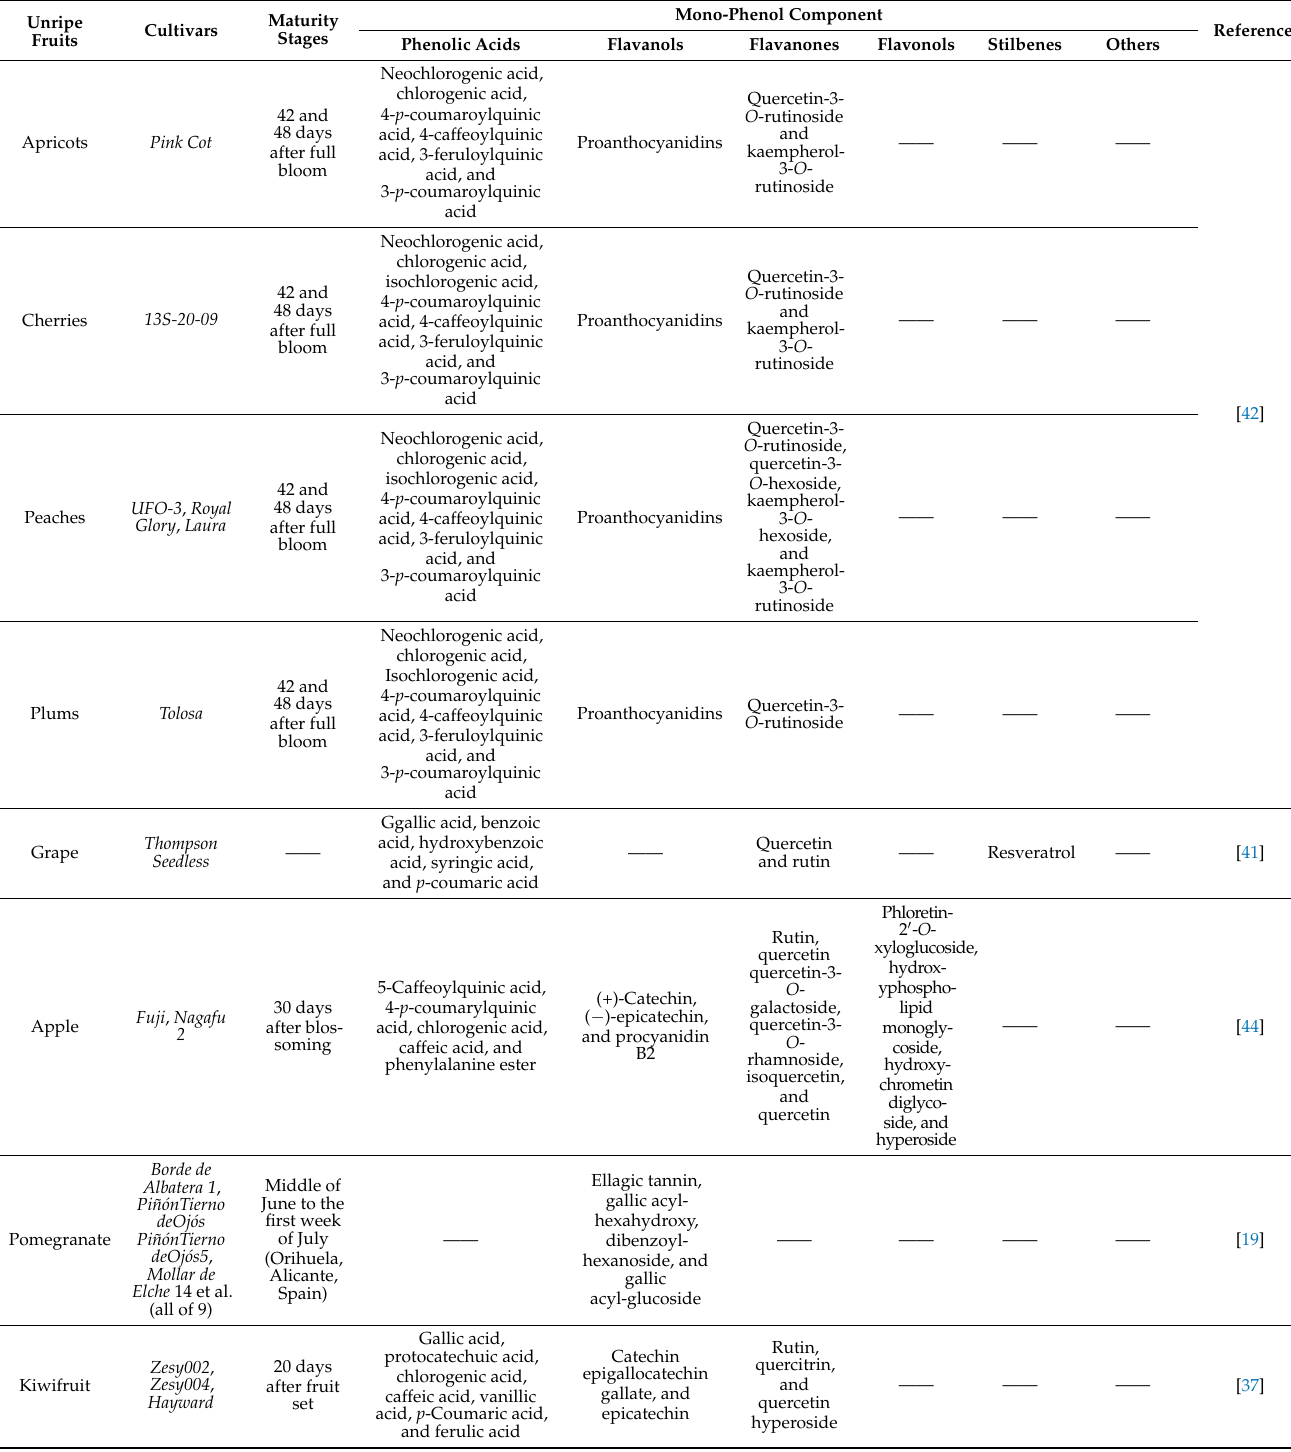
Table 2. Phenolic compounds detected in unripe